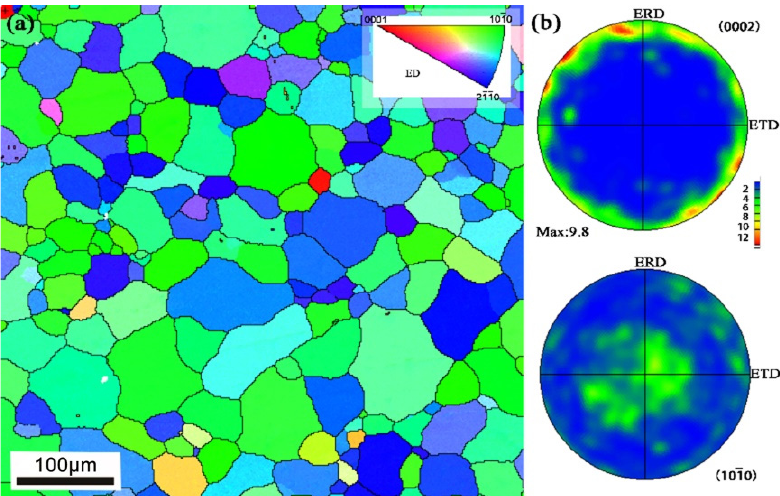
Figure 1. ( a ) EBSD map using inverse pole figure (IPF) coloring shows the initial microstructure of as-received AZ31 magnesium alloy rod. ( b ) The corresponding pole figure of as-received AZ31 magnesium alloy rod.